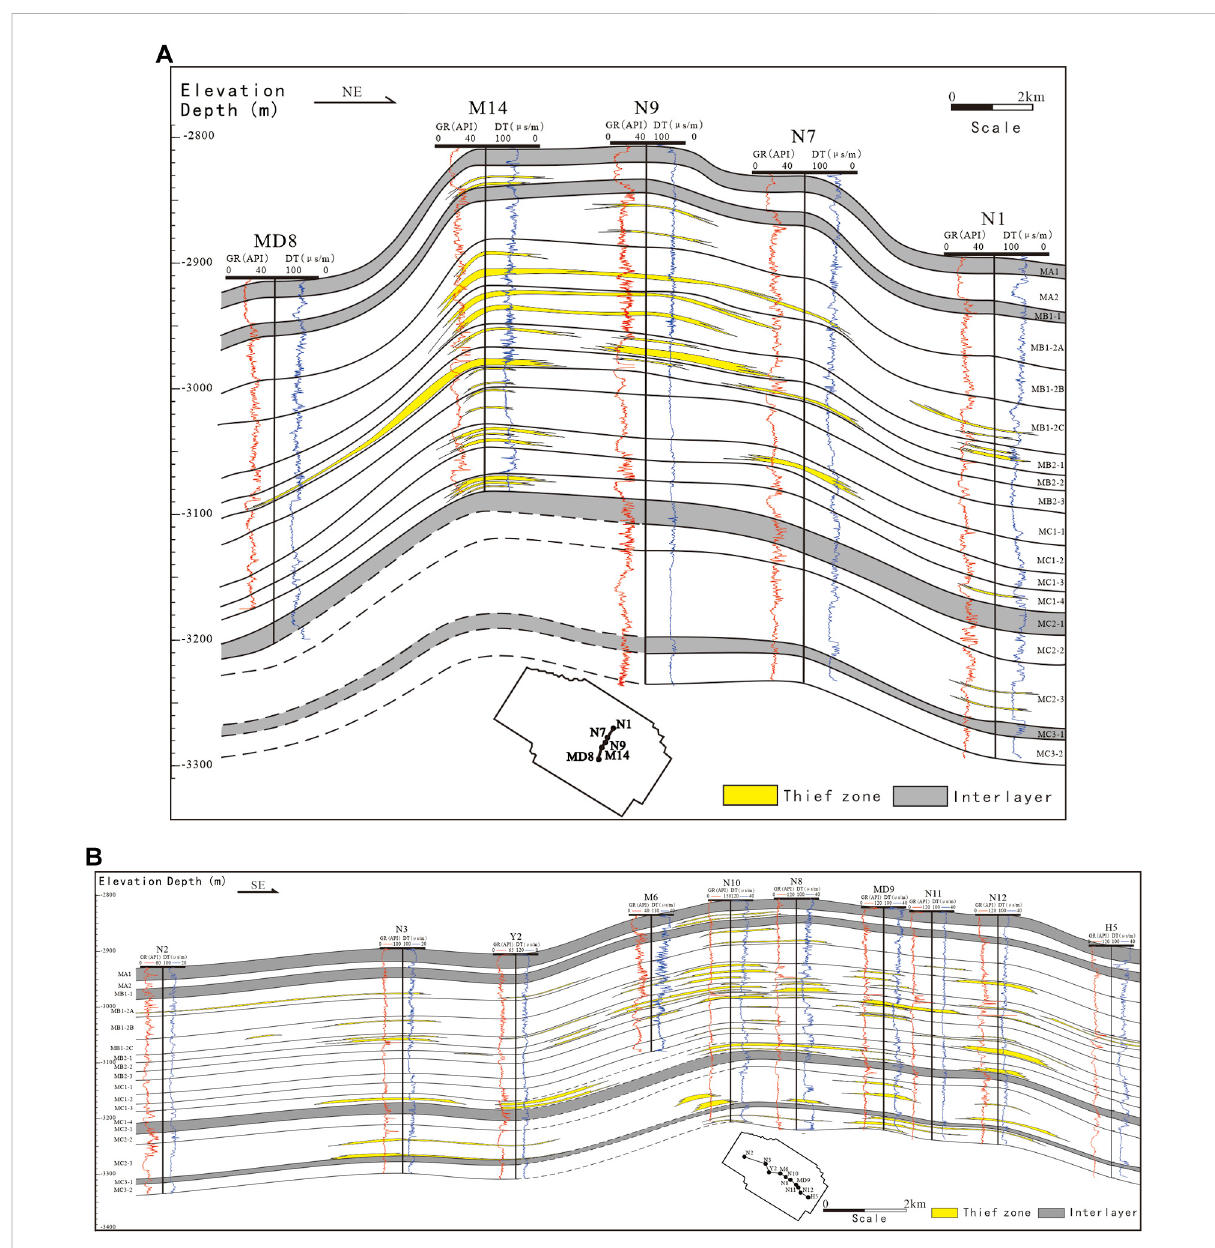
Well pro fi le with the description of thief zones: (A) along the short axis (SW-NE trending) and (B) along the long axis (NW-SE